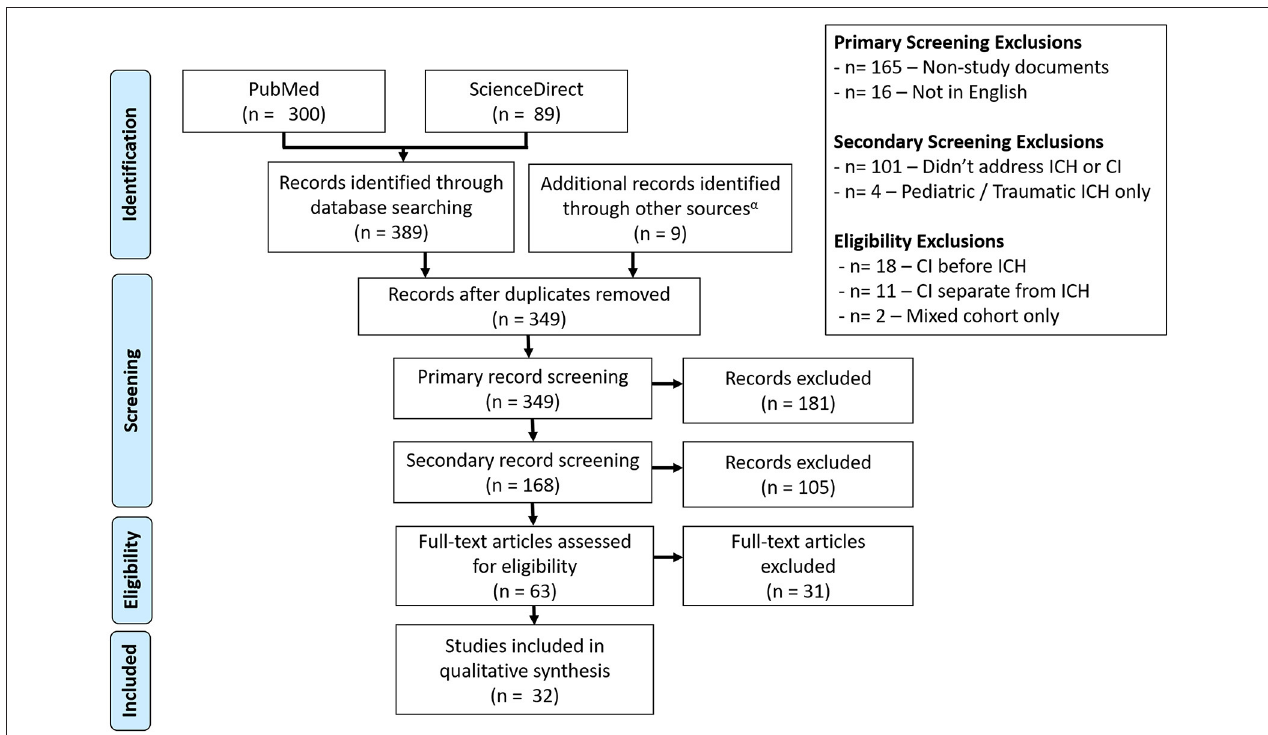
FIGURE 1 | Consort diagram for the selection of studies. A total of 32 studies were selected from the Science Direct and PubMed databases, with screening performed to remove articles that did not address post-ICH CI or non-spontaneous adult ICH cases.